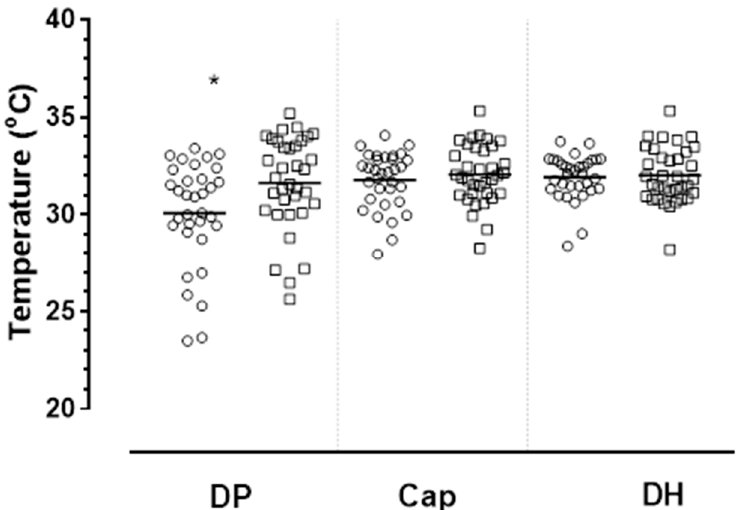
Figure 3. Mean skin temperature at each of three ROI regions represented by finger-tip (distal phalange, T DP ), capitate bones (T Cap ) and forearm at distal humerus/ulner (T DH ) of residents with dementia/AMT < 8 (D) (open circles, O) and residents without a confirmed diagnosis of dementia/AMT ≥ 8 (ND) (open square □ ). *Significant difference between mean temperature for T DP of residents D vs. ND group ( p = 0.01). Horizonal bars represent mean values.